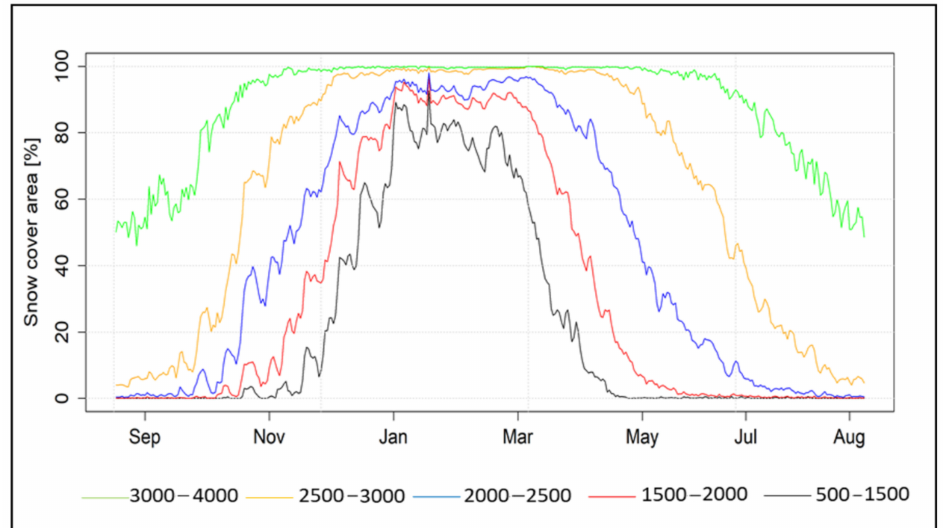
Figure 4. Elevation zone-based snow cover evolution with 1000 m intervals.